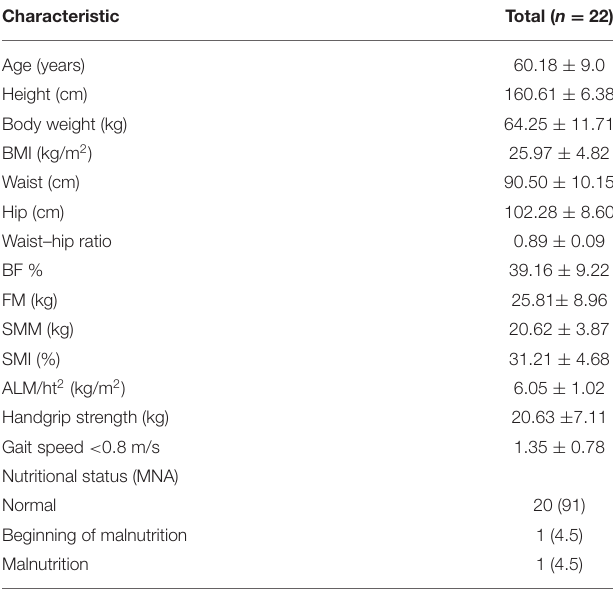
TABLE 1 | Baseline general and clinical characteristics of the study participants.